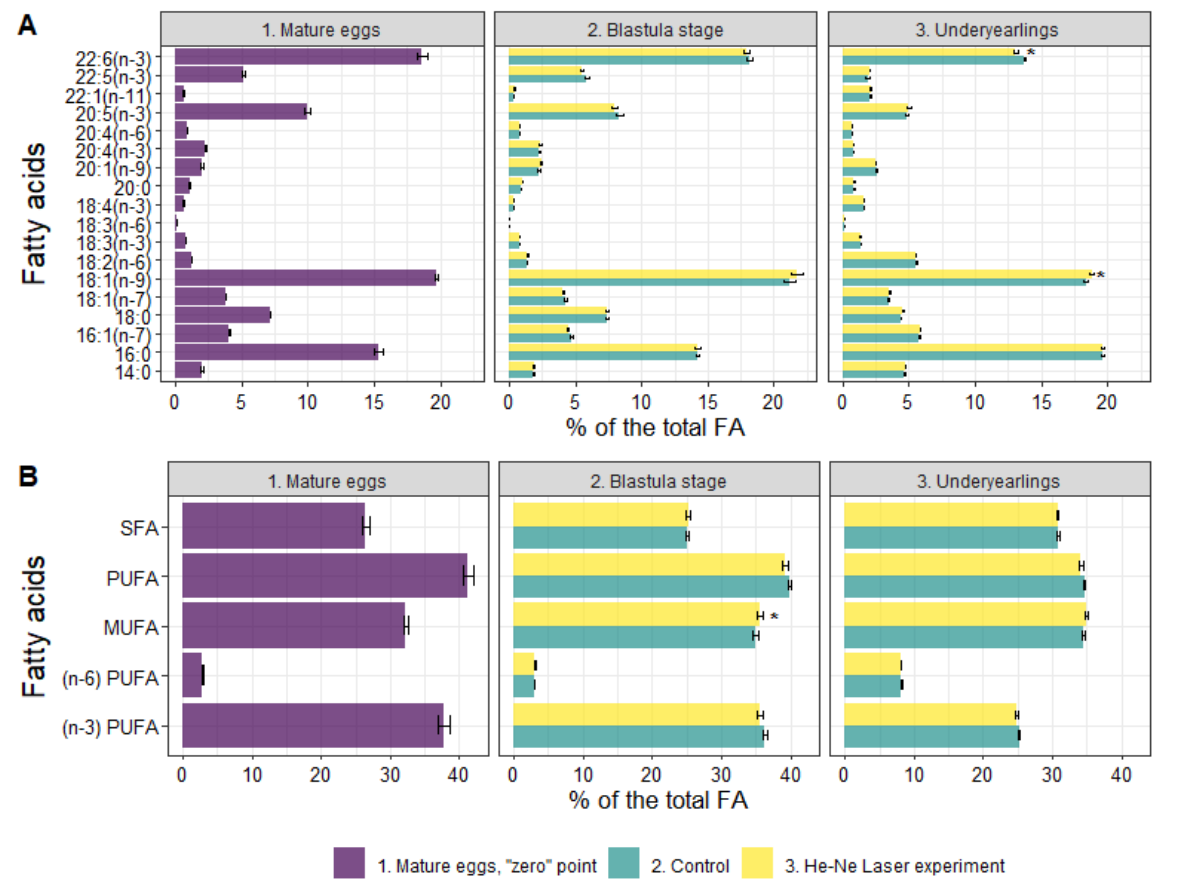
Figure 5. Fatty acid profile in mature (unfertilized) eggs, in blastula stage and in underyearlings of Atlantic salmon in control and experiment. * — significantly different ( p < 0.05) between groups. SFA — saturated fatty acids, PUFA — polyunsaturated fatty acids, MUFA — monounsaturated fatty acids. Table 2. Certain metabolic ratios in mature (unfertilized) eggs, in blastula stage and in underyearlings of Atlantic salmon in control and experiment.